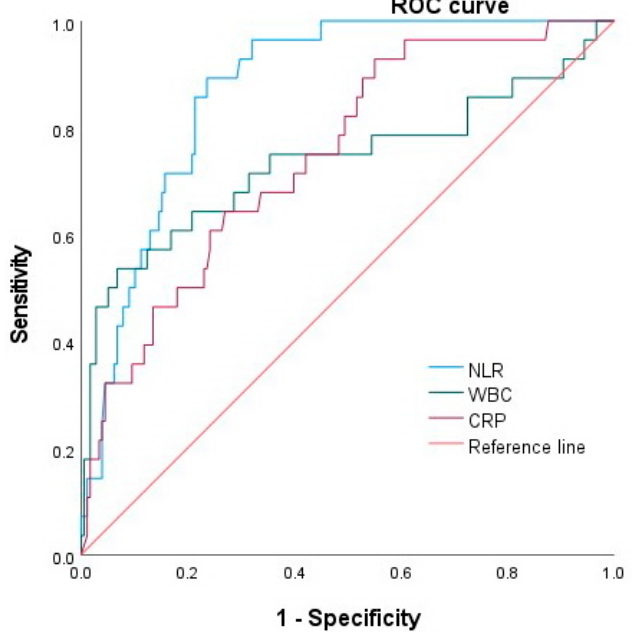
Figure 2. Receiver operating characteristic curve for NLR, WBC and CRP as predictors of severe acute cholangitis. NLR, neutrophil–lymphocyte ratio; WBC, white blood cell; CRP, C-reactive protein.